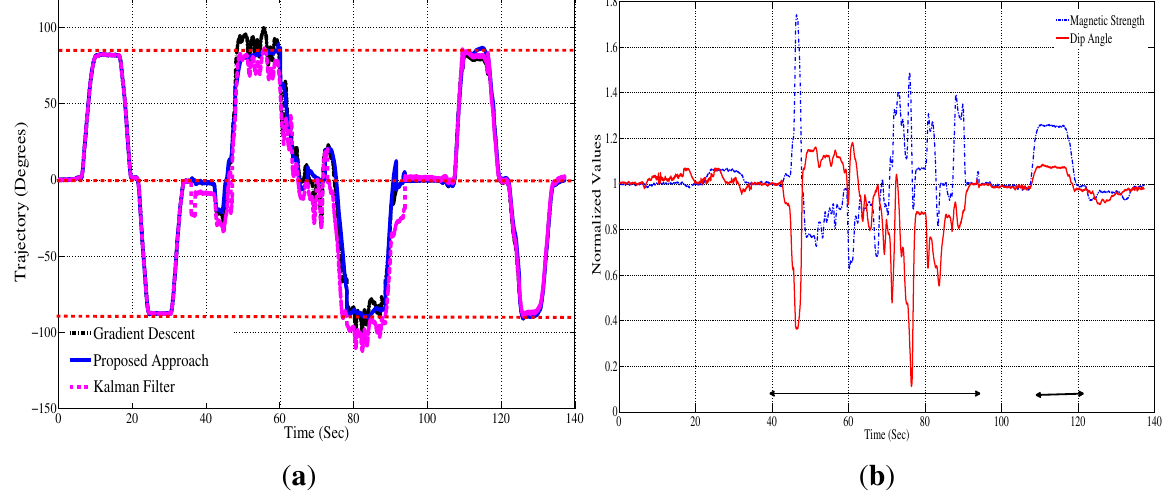
Table 2. Comparison of maximum peak-to-peak heading error and RMS error using various